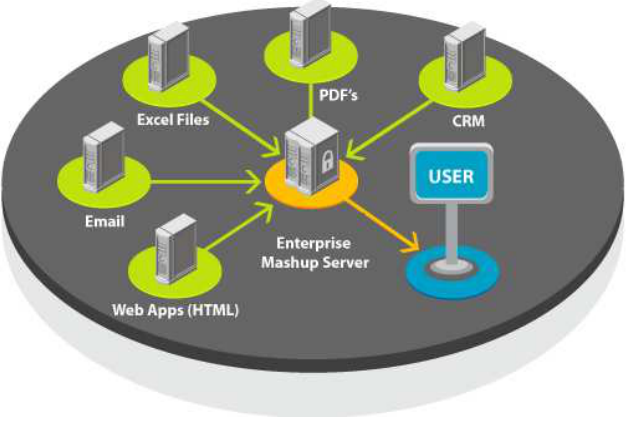
Figure 2. Enterprise Mashup Server as a